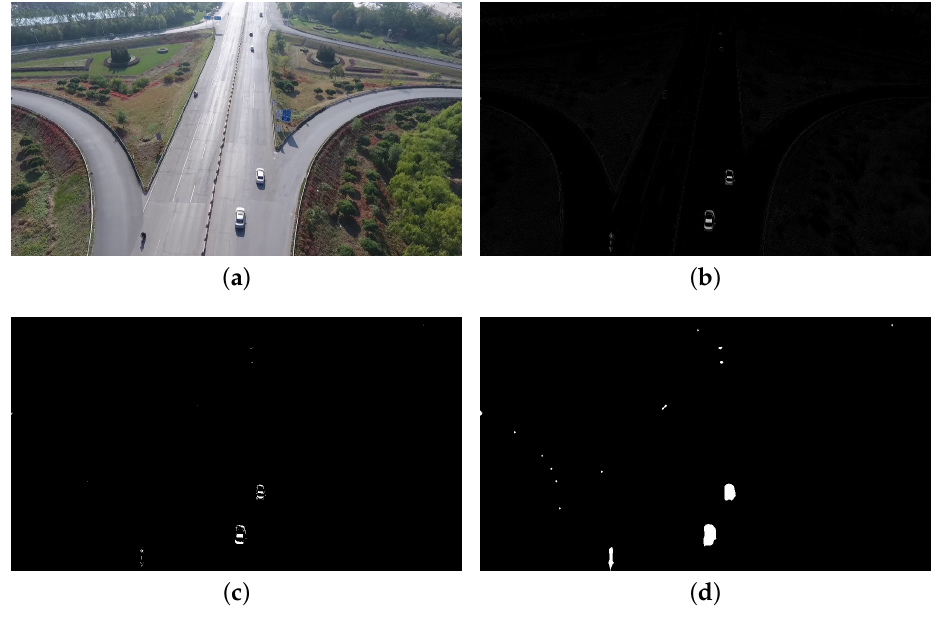
Figure 15. The results of vehicle detection(moving background): ( a ) a selected frame of video stream; ( b ) initial difference image; ( c ) the result of segment; and ( d ) the result of